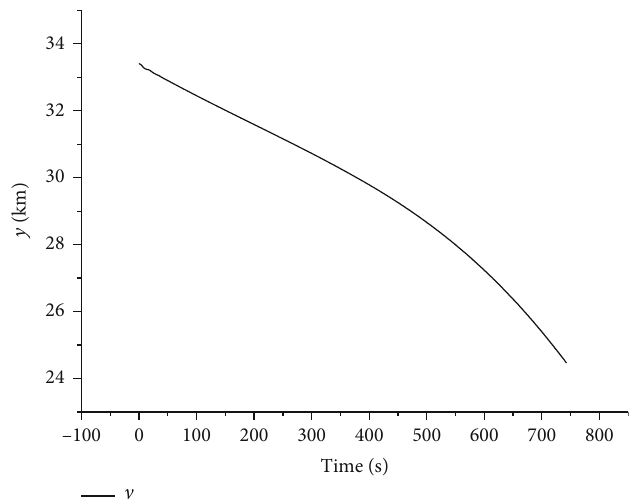
Figure 12: Altitude for the quasiequilibrium glide method.